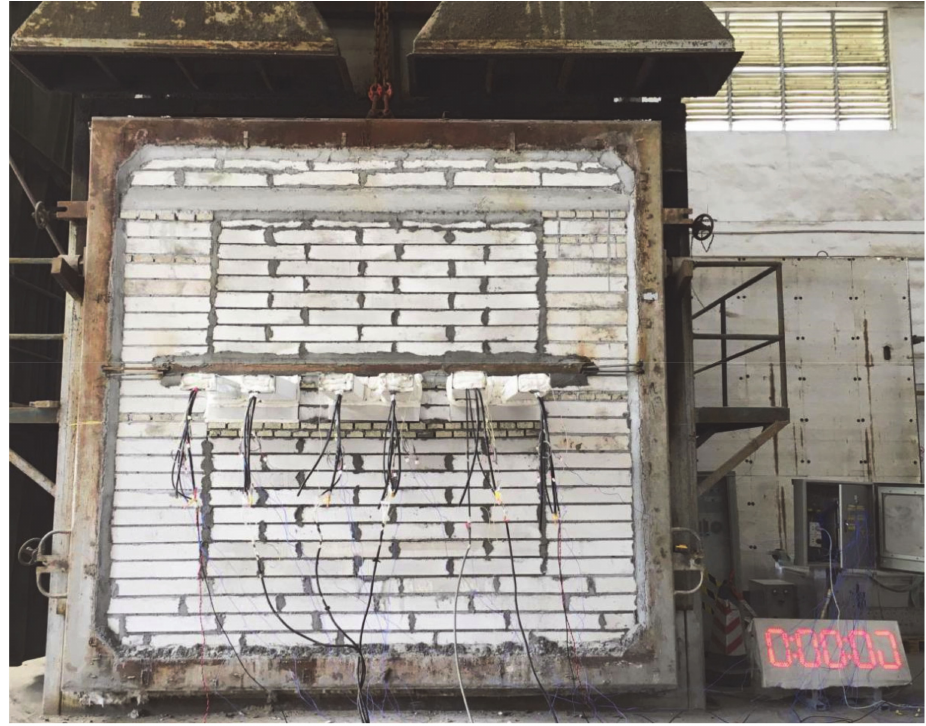
Figure 6. Experimental site after